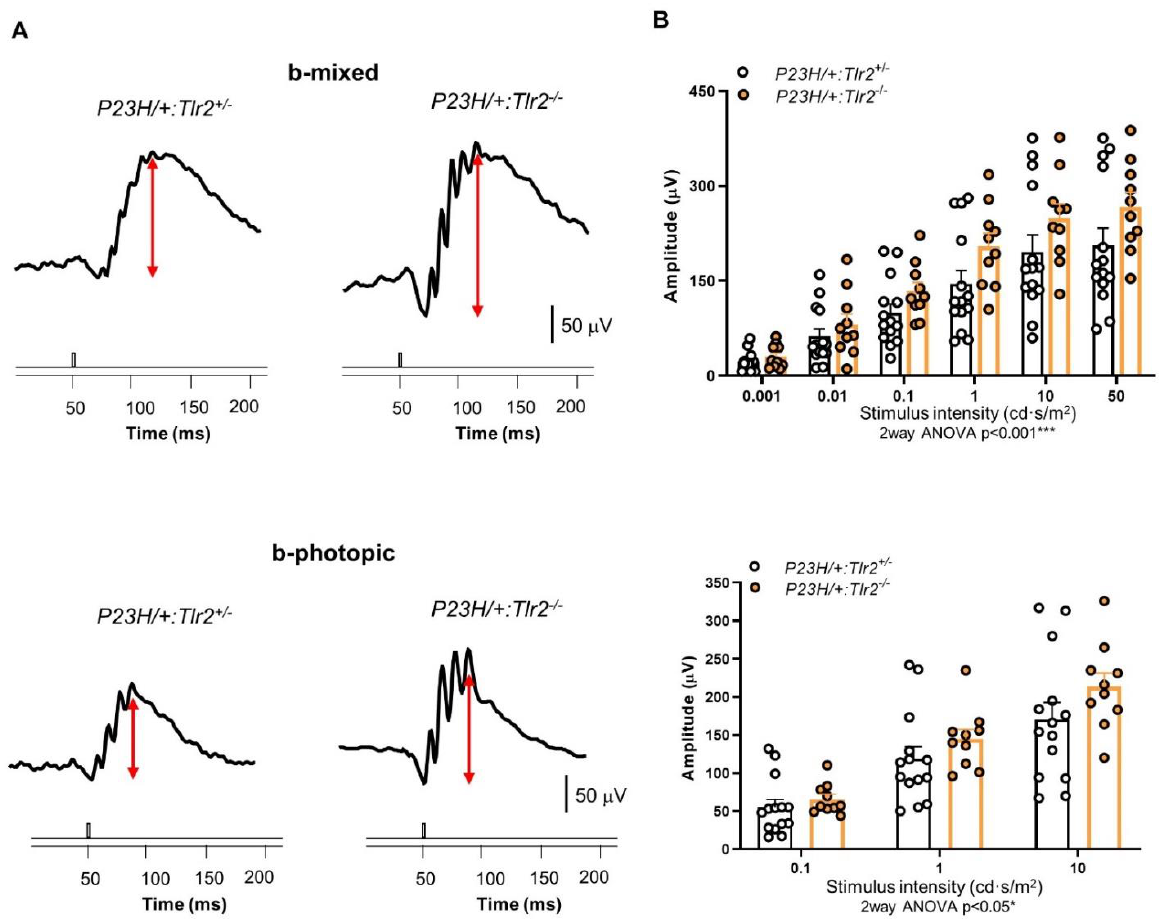
Figure 3. ERG response of P23H/+:Tlr2 +/ − and P23H/+ : Tlr2 − / − mice. ( A ) Representative ERG responses of 4-month-old P23H/+:Tlr2 +/ − and P23H/+:Tlr2 − / − mice to light stimuli of 50 cd · s/m 2 (b-mixed) or 10 cd · s/m 2 (b-photopic). The value of the scale bar is indicated in the figure. ( B ) Graphs show mean ERG wave amplitudes, plotted as a function of light stimulus. Amplitudes of rod and cone mixed responses (b-mixed waves) to the indicated light intensities were recorded under scotopic conditions after overnight adaptation to darkness. Amplitudes of cone responses (b-photopic waves) to the indicated light intensities were recorded under photopic conditions after 5 min of light adaptation (30 cd · s/m 2 ). Dots represent individual mice and bars represent the mean (+SEM) for each group. n = 10–14 animals per group. *** p < 0.001; * p < 0.05 (2way ANOVA).